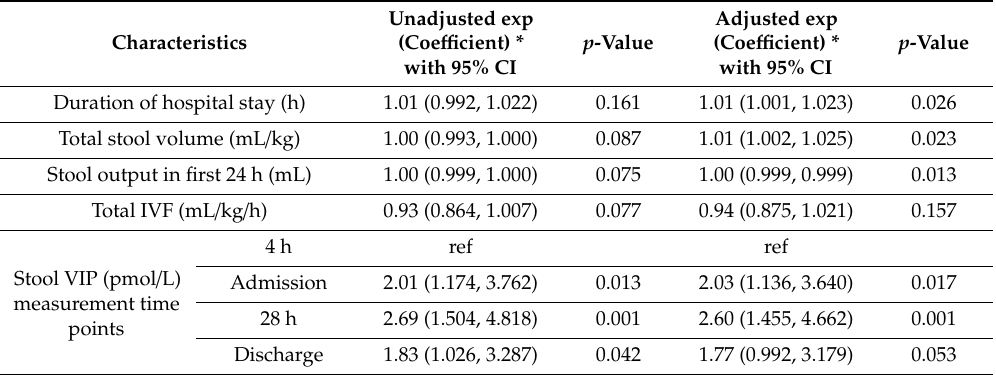
Table 3. Associations of stool water VIP (pmol / L) in patients with cholera and severe dehydration / hypovolemic shock at four di ff erent timepoints before and after rehydration using generalized estimating equations